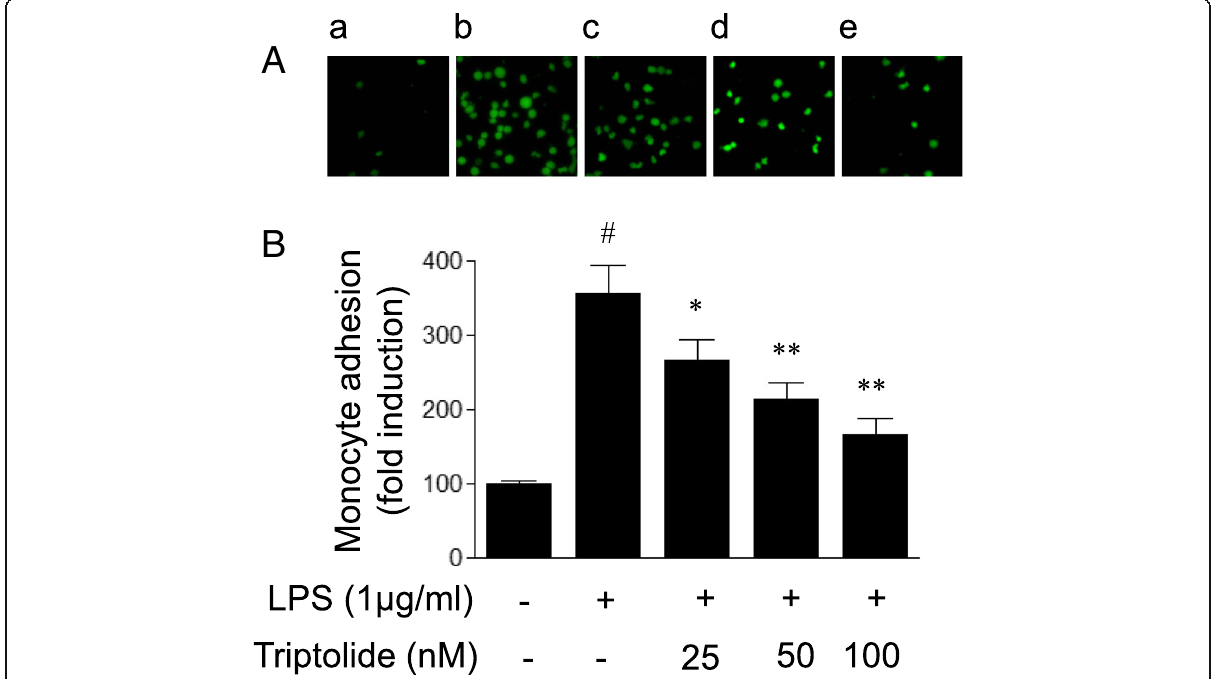
Fig. 4 The effects of triptolide on lipopolysaccharide (LPS)-induced monocyte adhesion to human umbilical vein endothelial cells (HUVECs). HUVECs were treated with LPS (1 μ g/ml) in the presence or absence of triptolide (25, 50 or 100 nM) for 6 h, and subsequently co-cultured with fluorescence-labeled THP-1 cells for 30 min. ( a ) Representative images of fluorescence staining of monocyte adhesion to HUVECs. Magnification, × 200. HUVECs were exposed to (a) vehicle (control), (b) LPS or LPS with triptolide at the concentration of (c) 25, ( d ) 50 or ( e ) 100 nM prior to incubation with fluorescence-labeled THP-1 cells. ( b ) The adhesion ability of THP-1 cells was assayed using a spectrofluorometer. Data are expressed as the mean ± standard error of the mean. * p < 0.05 and ** p < 0.01, compared with LPS treatment alone. # p < 0.05, compared with